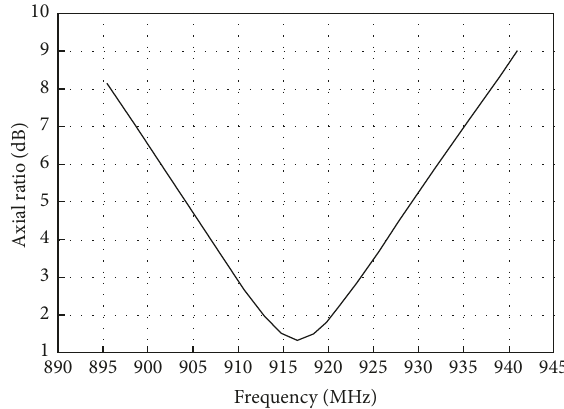
Figure 8: Simulated axial ratio of the proposed antenna.